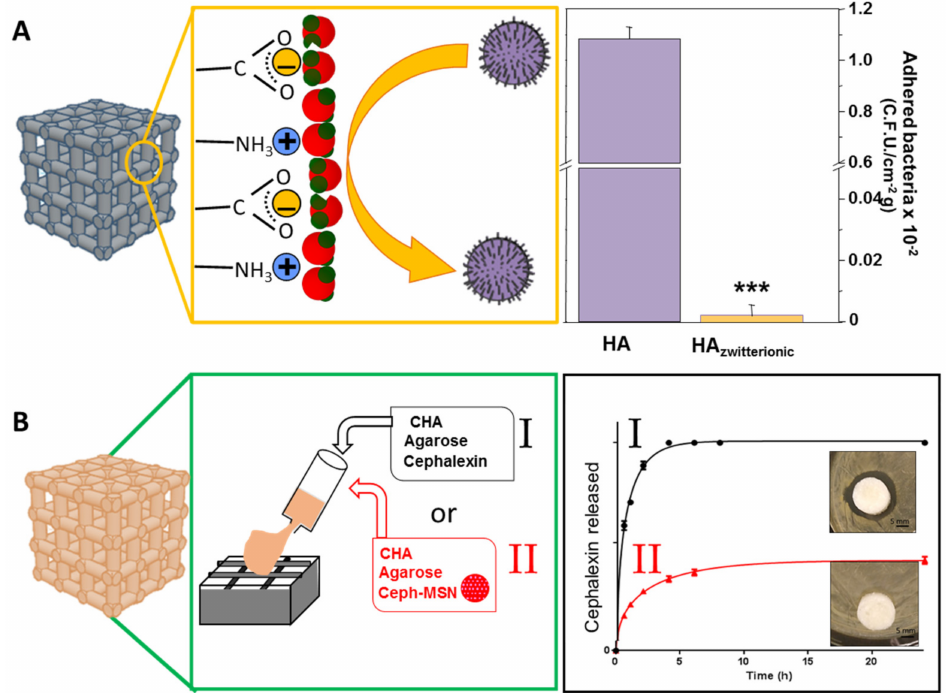
Figure 6. Strategies used to combat bone infection: ( A ) (left) schematic representation of the water molecules disposition on the zwitterionic surface that generates a strong repulsive force against bacteria as they approach the surface. (right) Bacteria attached onto HA and HA-Zwitterionic scaffold surfaces. (***) Statistical significance p < 0.001. Reproduced with permission from S á nchez- Salcedo et al. [60], J. Mater. Chem. B; published by Royal Society of Chemistry, 2013. ( B ) (left) Two methodologies (I and II) designed for the incorporation of antibiotics into the scaffold. (right) Release profiles from these scaffolds and agar diffusion tests. Reproduced with permission from Paris et al. [32], Acta Biomater.; published by Elsevier,